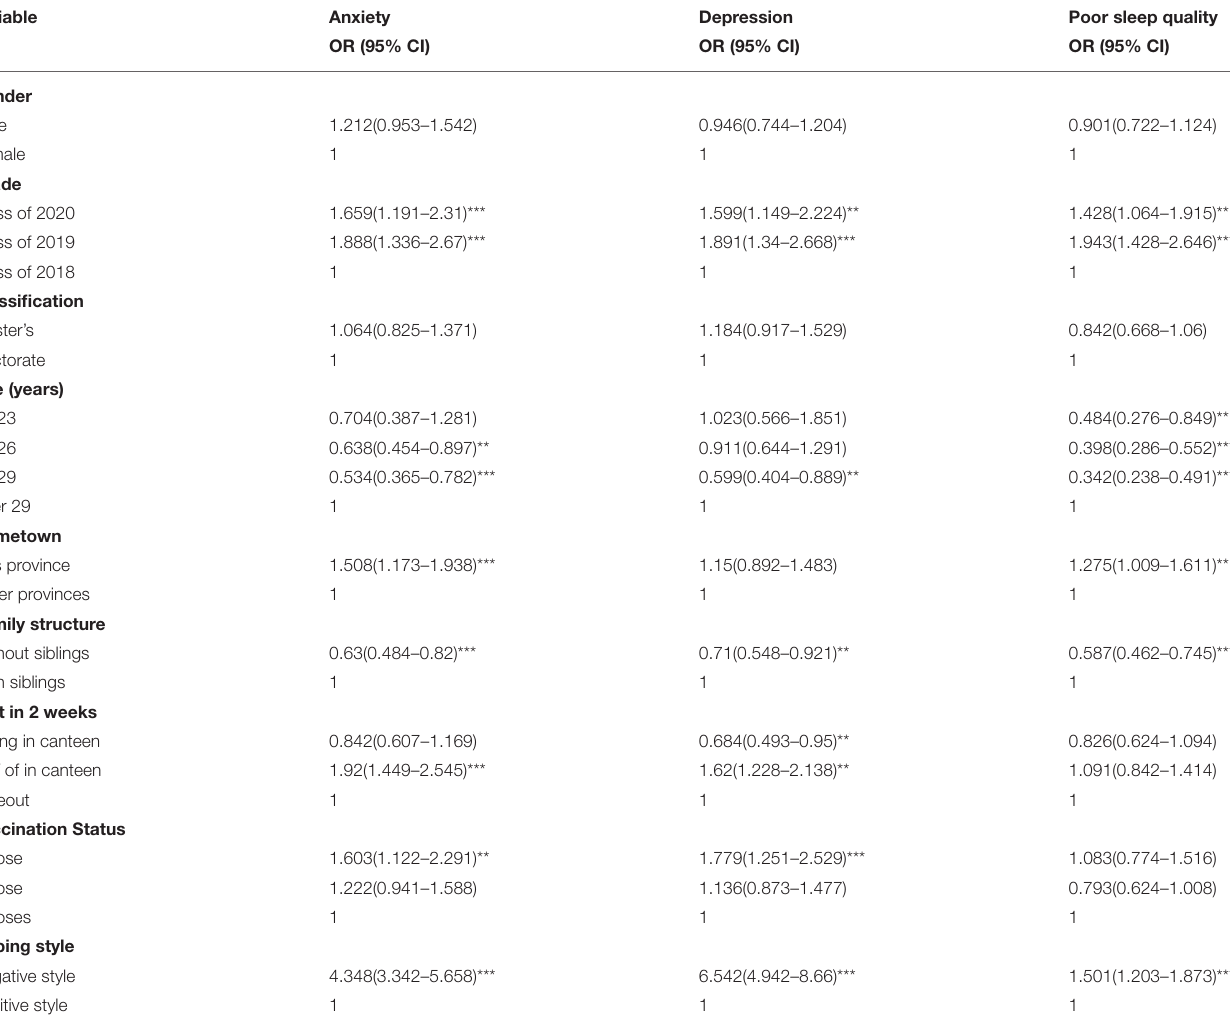
TABLE 2 | Factors associated with probable anxiety, depression and sleep quality problem using univariate logistic regression analyses among 1,336 Chinese medical